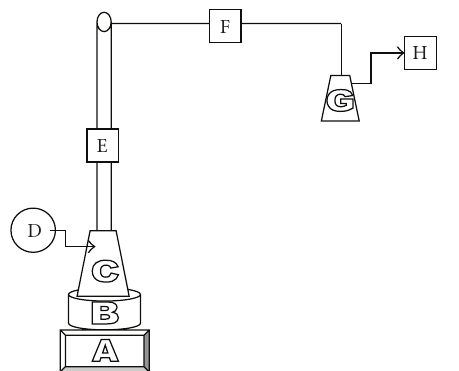
Figure 1: Arrangement for the determination of free and bound SO 2 by the modified Monier-Williams method. (A) Heater, (B) glycerin bath, (C) flask 1, (D) air pump, (E) refrigerant, (F) con- nector, (G) flask 2, (H) air output.